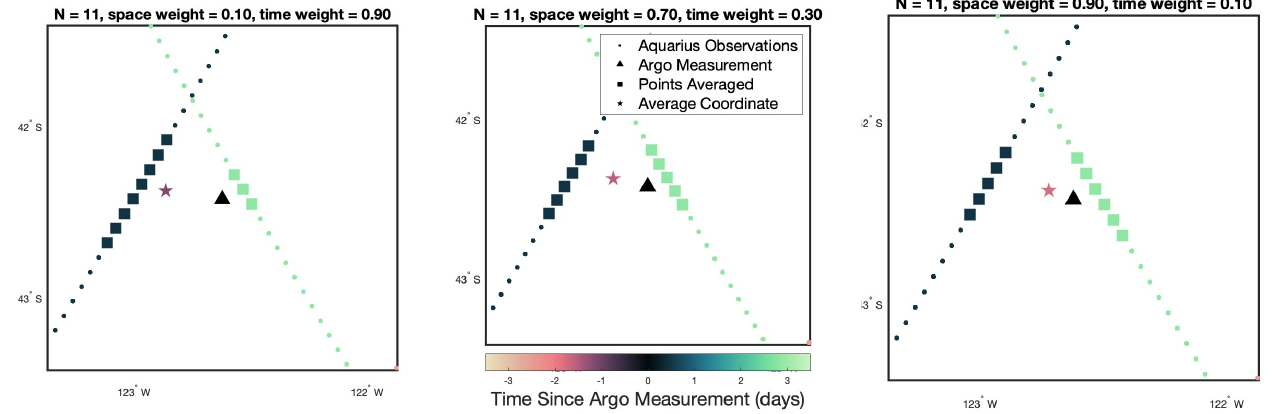
Figure 3. Aquarius measurements selected for averaging by the N closest method ( (cid:4) ) for a random Argo float in the PAC region when different values of N and space_weight are used. The coordinate of the average satellite observation ( (cid:70) ) is also shown along with the location of the Argo float ( (cid:78) ). The difference between the averaged SSS of these chosen observations and the SSS measured by the Argo float is found for all of the Argo floats in the given region and the RMS of these differences is used as a measure of the effectiveness of any given set of N and space_weight parameters.